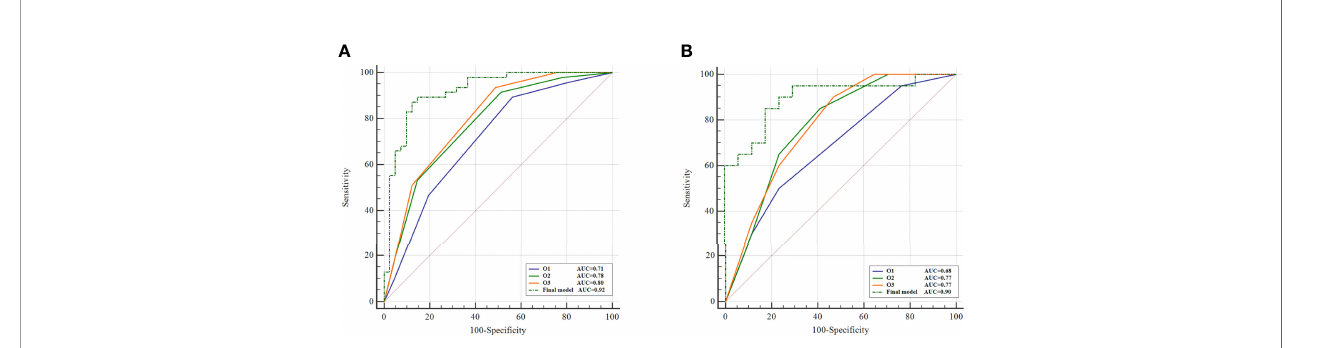
FIGURE 2 | Comparison of BI-RADS analysis and radiomics. ROC curves of BI-RADS analysis and the fi nal model of radiomics on training cohort (A) and external validation cohort